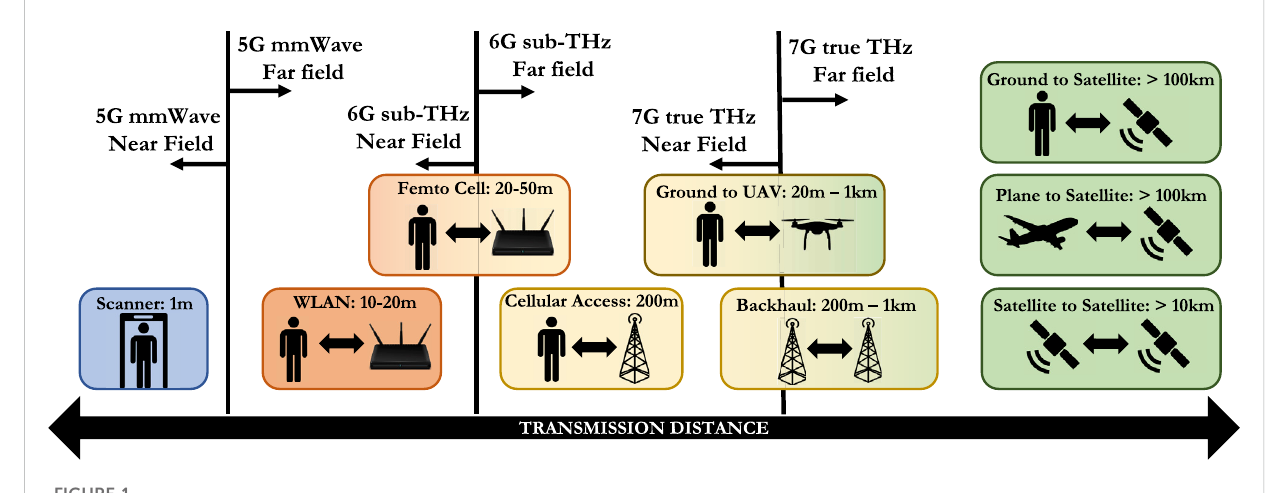
FIGURE 1 Expansion of near- fi eld use cases from 5G through 6G to 7G networks.